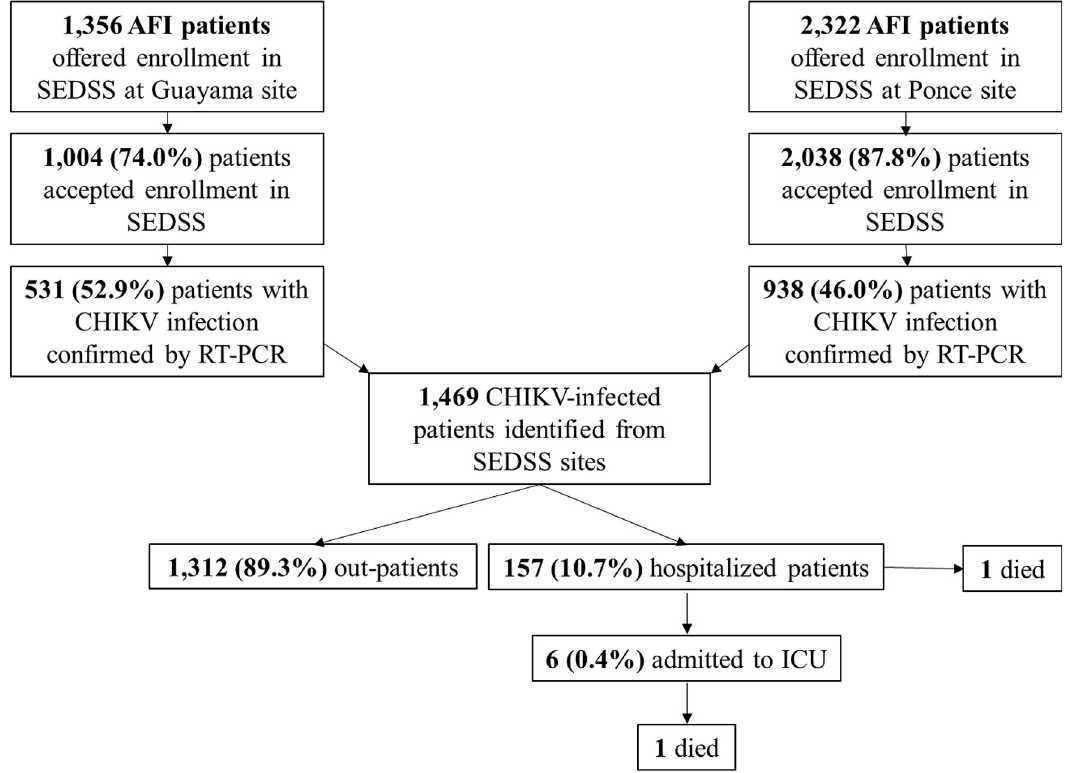
Fig 1. Identification and outcome of chikungunya virus-infected patients enrolled in the Sentinel Enhanced Dengue Surveillance System, May–December 2014.